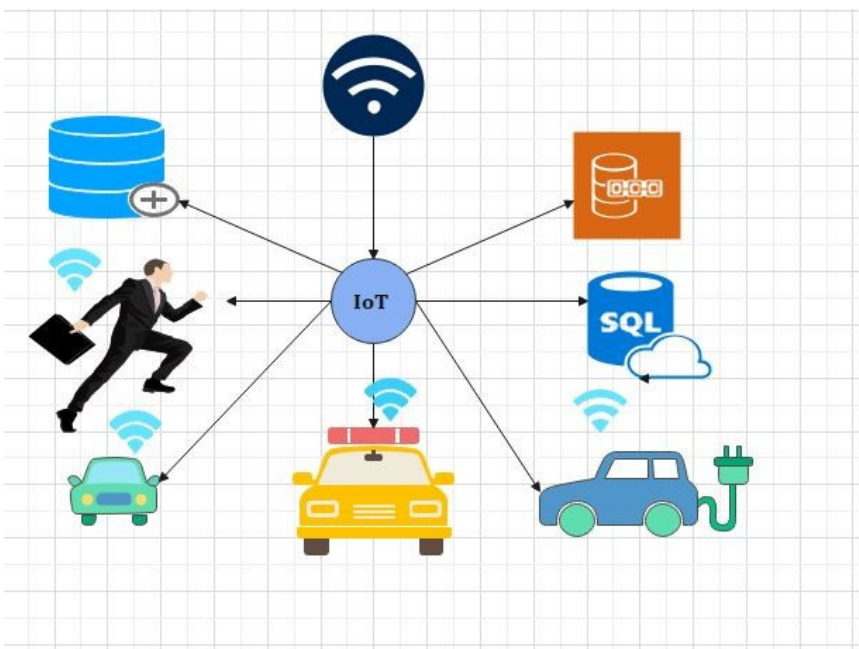
Figure 1. Industrial IoT and its applications in real life.